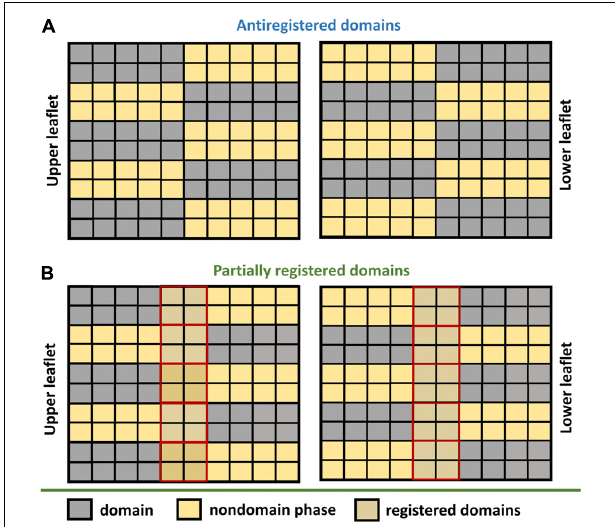
FIGURE 2 | Domain anti-registration versus partial registration. (A) Domains are classified as antiregistered when the domains localized in one leaflet (gray squares) are aligned with the nondomain region in the other leaflet (yellow squares). Such an arrangement is possible only if the domain and nondomain subregions occupy an equal area of the bilayer. (B) Higher amount of one of the regions inevitably leads to transversal overlap between the domain and nondomain subregions (yellow-gray squares surrounded by solid